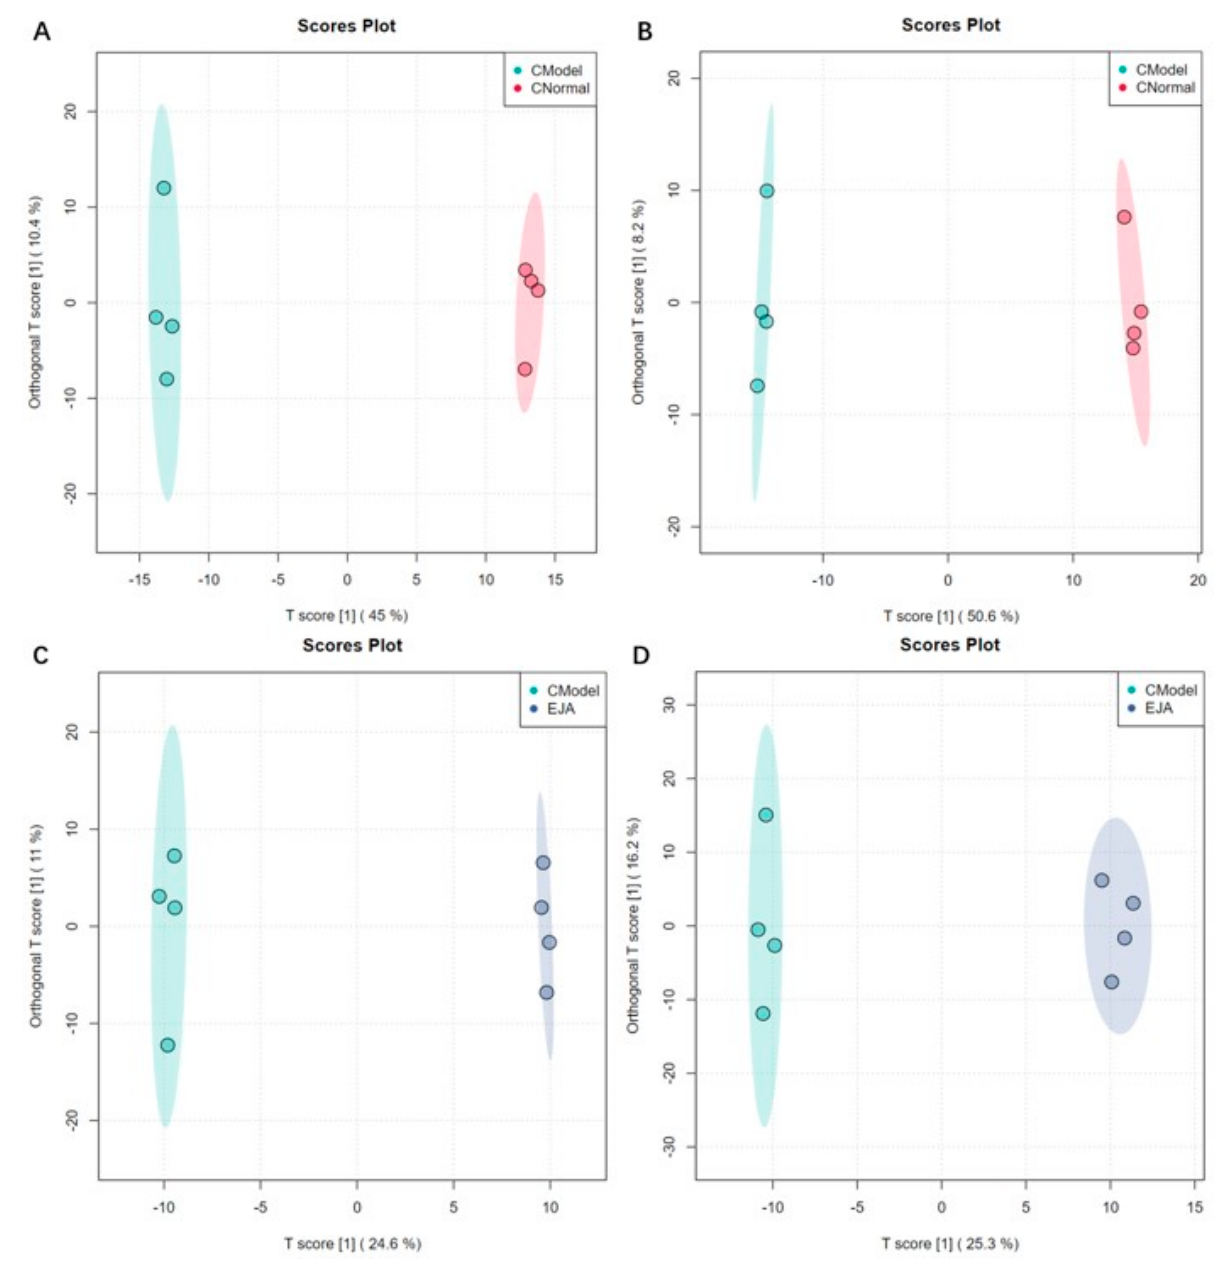
Figure 5. Sample distribution of different groups in OPLS-DA mode. ( A ) the normal group and the model group in positive ion mode; ( B ) the normal group and the model group in negative ion mode; ( C ) the model group and the treatment group in positive ion mode; and ( D ) the model group and the treatment group in negative ion mode.